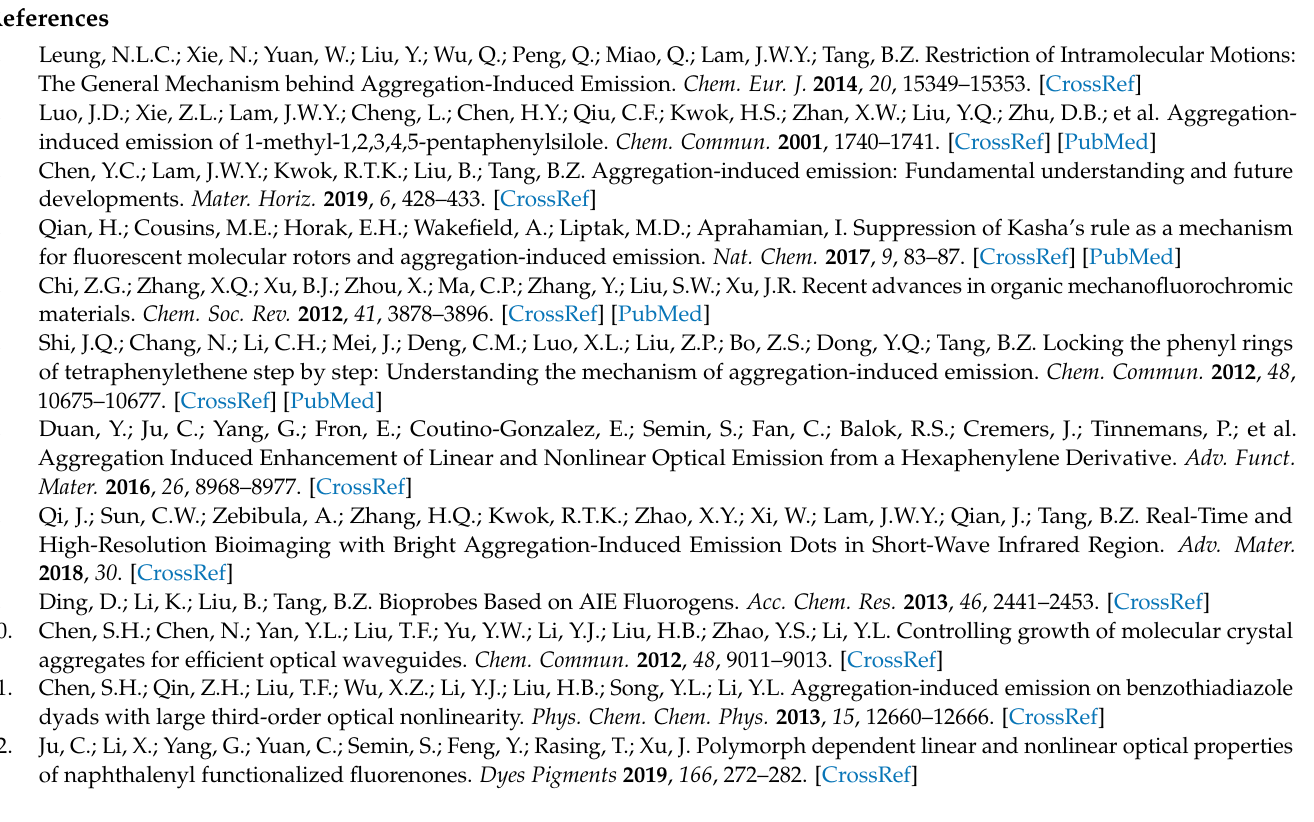
BTN, Figure S3: HRMS pattern of BTN, Figure S4: XRD patterns of BTN crystals with two structures and simulated XRD patterns of single crystal XRD data from rod-like single crystals, Figure S5: The AFM image of a typical single micronwire of BTN, Figure S6: The fluorescence confocal microscope of BTN nanowires, Table S1: The maximum absorption and fluorescence emission peak of BTN in different ratios of hexane and